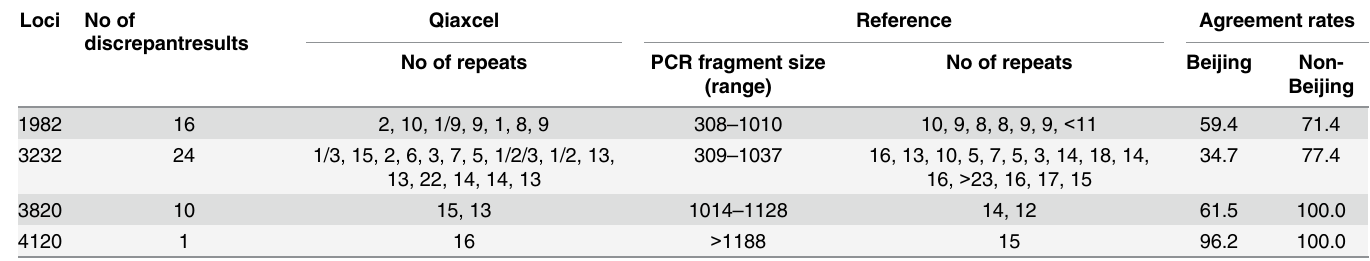
Table 3. Discrepant results for hypervariable loci. Loci No of